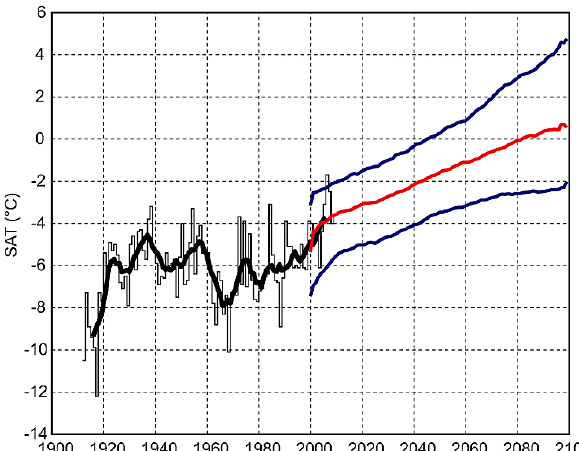
Fig. 2. The official mean annual surface air temperature record at Svalbard Airport. The bold line represents a 7year Gauss-filtered series of MAAT with three standard deviations. The distribution of the 32 downscaled future scenarios are displayed as percentiles be- tween 2000 and 2100, where the red line is the median and the blue lines represent the 10% and 90% percentiles, respectively. Note that the observed annual temperature closely matches the scenario median in the 10year overlap period, with the extreme year of 2006/2007 being outside even the 90% percentile (Isaksen et al.,